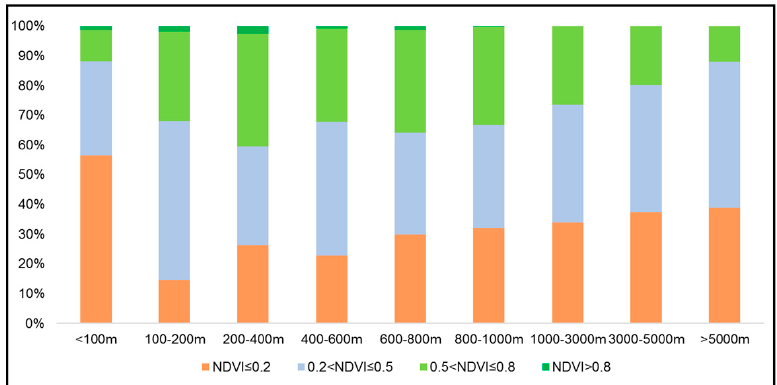
Figure 7. Area ratio of global vegetation distribution and altitude.